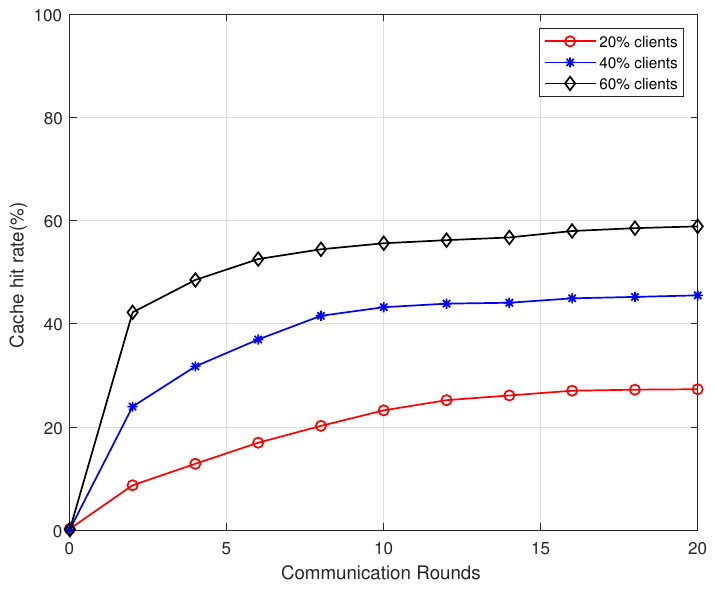
Figure 3. Cache hit rate vs communication rounds for datasts of MovieLens 100K.